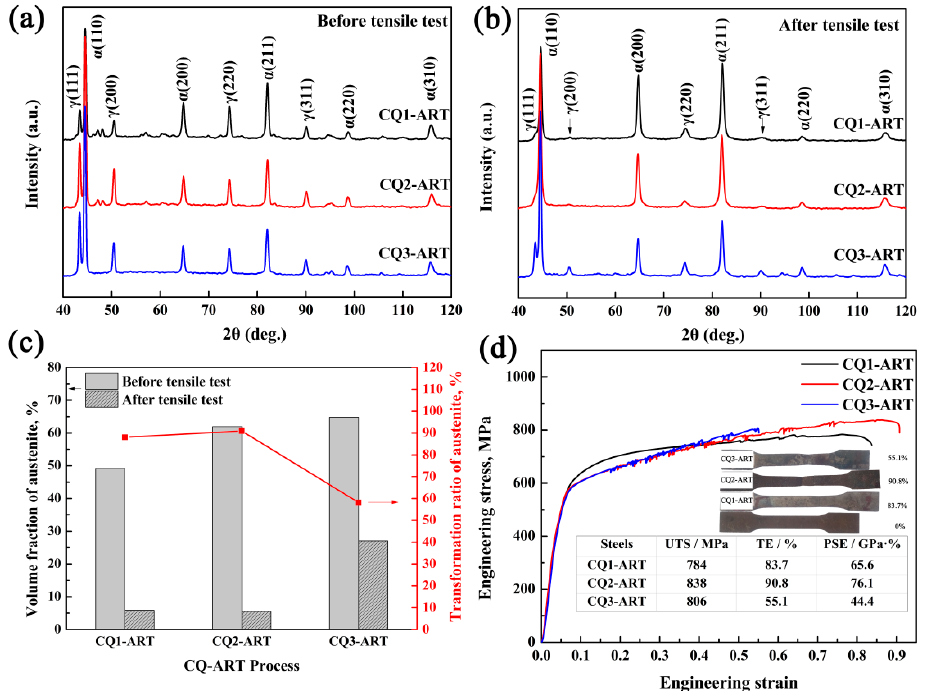
Figure 4. ( a ) XRD pattern of the before tensile test samples, ( b ) XRD pattern of the after tensile test samples, ( c ) austenite fraction calculated using Equation (1) and transformation ratio of austenite, and ( d ) engineering stress-strain curves.